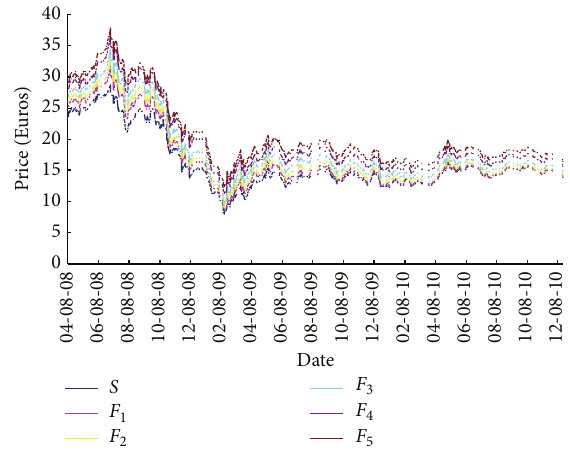
Figure 1: Spot and futures prices of emissions